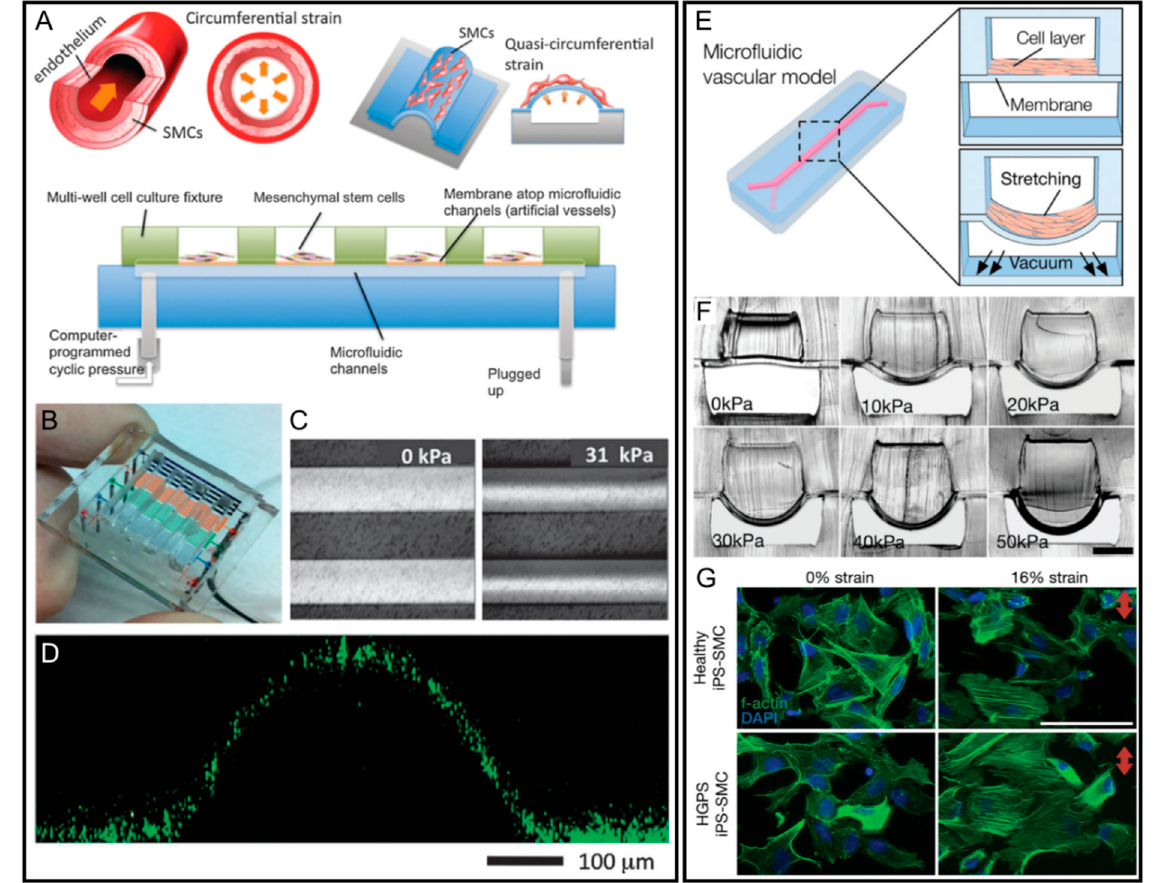
Figure 5. Vessel-on-a-chip platforms with microfluidic actuators. ( A ) Schematic illustration and ( B ) photography of the microfluidic artificial vessel chip. ( C ) The corresponding membrane deformations of 200 μ m wide microchannel under the hydrostatic pressure from 0 to 31 kPa. ( D ) Confocal fluorescent cross-sectional image of deformed PDMS membrane on the 500 μ m microchannel with the application of 21 kPa static pressure. Reproduced with permission from [86]. ( E ) Schematics of the pressure-controlled microfluidic vascular model and the biomimetic pulsatile blood flow strain effects. ( F ) Photographic images of microchannel cross-section deformation under different vacuum pressures inside the underlying air channel. ( G ) Different morphologies of HGPS iPS-SMCs and iPS-SMCs under a 16% strain treatment for 24 h. Reproduced with permission from [87].